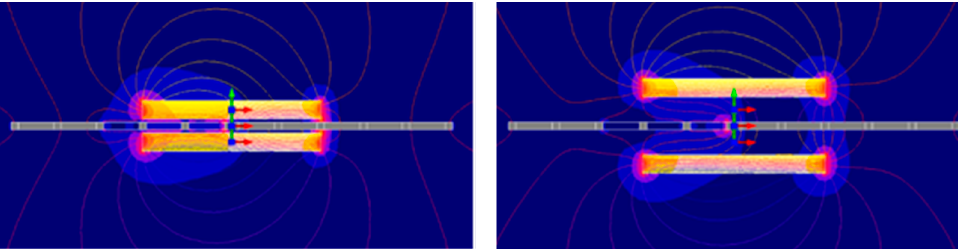
Figure 16. Distribution of magnetic flux lines in the active rotor area—Gadolinium (Gd) in the paramagnetic state (hot).